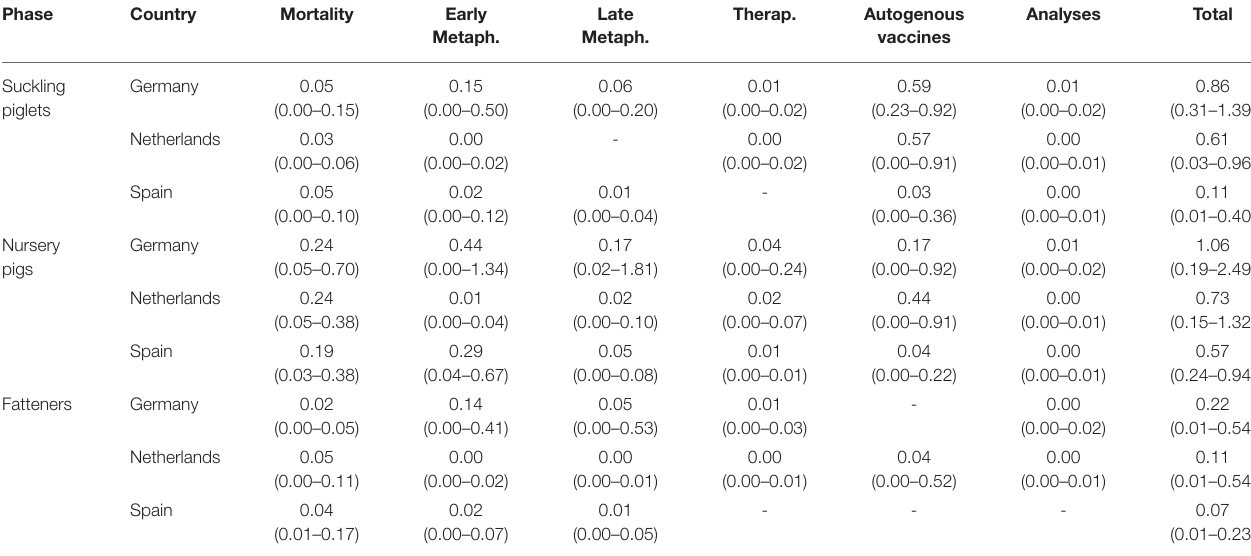
TABLE 2 | Mean losses, expenditures and total cost per animal in affected production units (in euros) for the different production phases in the countries of study. Phase Country Mortality Early